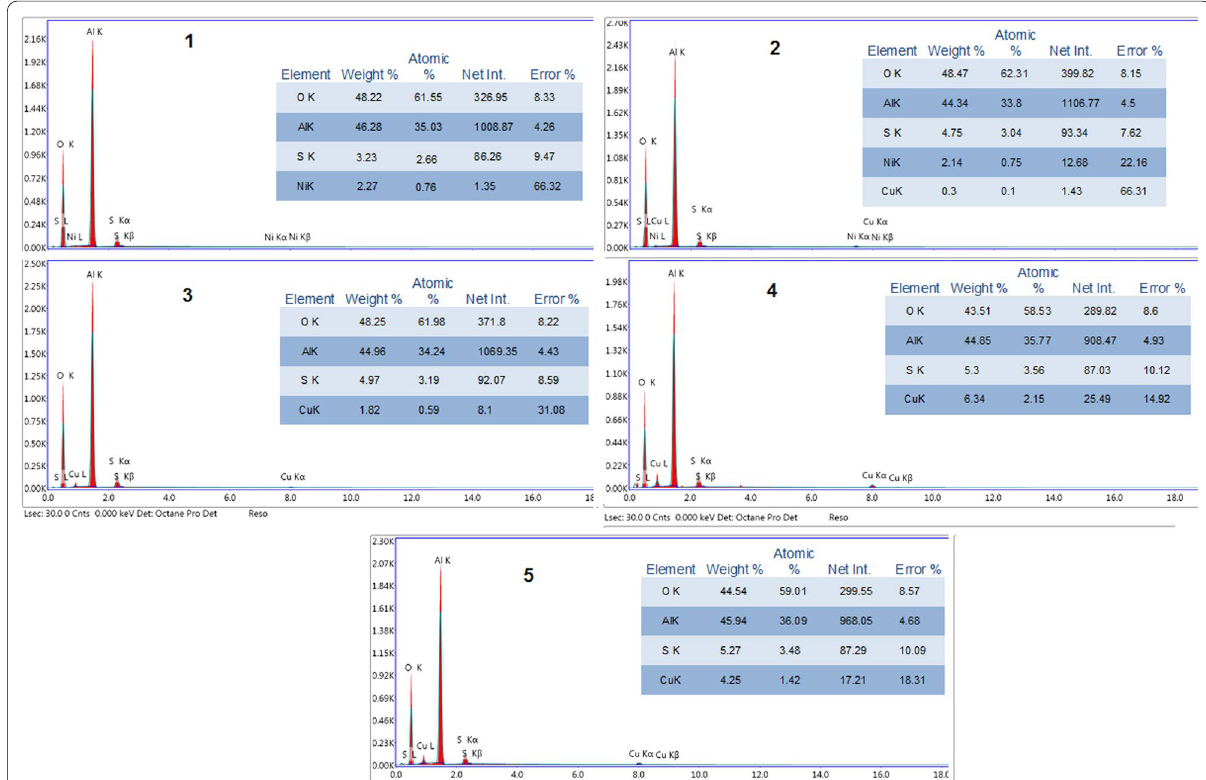
Fig. 4 EDX analysis of the electrolytically colored aluminum samples by (1) Ni, (2) mixture Ni/Cu, (3) Cu anodized for 20 min, (4) Cu anodized for 30 min and (5) Cu anodized for 60 min